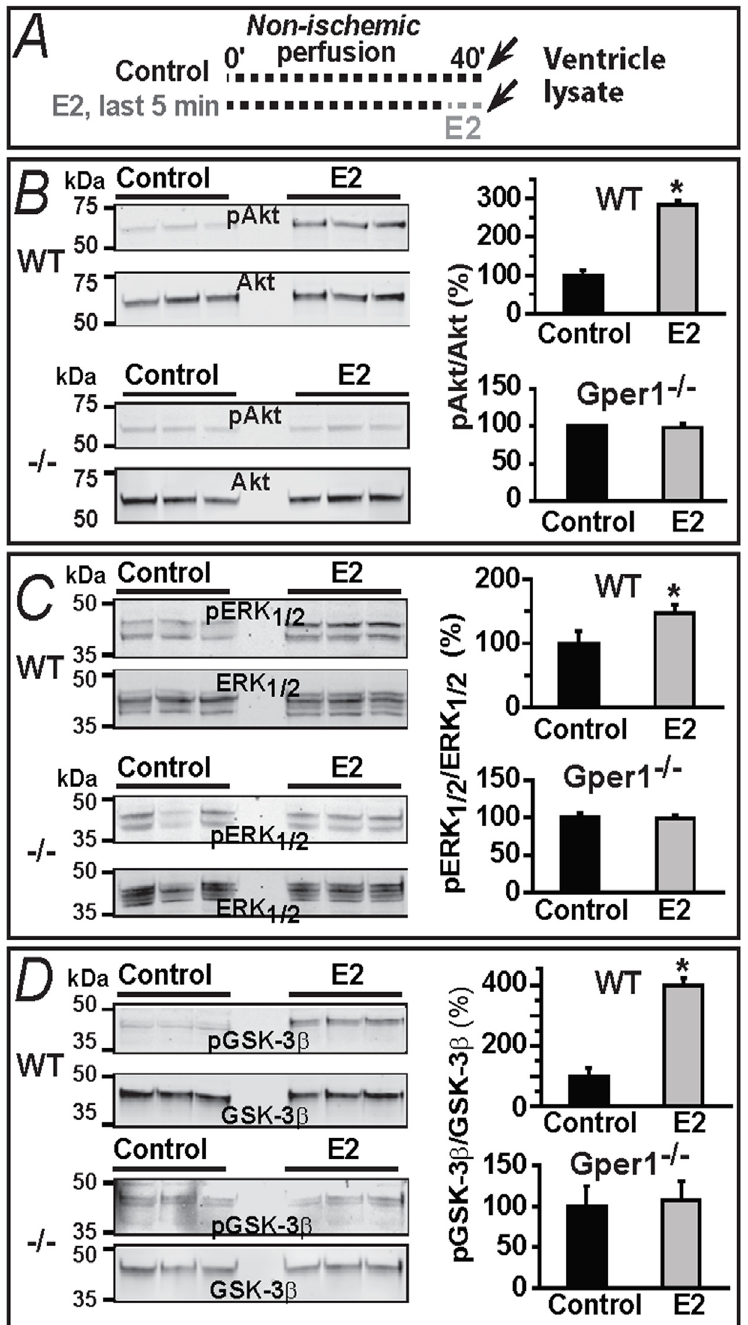
Fig 6. E2-induced increase in phosphorylation of Akt, ERK 1/2 and GSK-3 β is dependent on Gper1 gene expression and disappears with time for Akt and ERK 1/2 . A. Protocol used in panels B,C,D . Isolated hearts were either perfused 40 min with oxygenated KH solution or perfused with oxygenated KH for 35 min and for 5 min with KH plus 40 nM E2. B-D. Immunoblots and corresponding bar graphs show that 5 min “ pre- ischemic ” treatment with E2 provoked pAkt/Akt, pERK 1/2 /ERK 1/2 and pGSK-3 β /GSK-3 β ratios to increase in WT but not in Gper1 -/- samples. Control ratios were set to 100%. Values are mean ± S.E.M.; * , P < 0.05 control versus E2-treated group, n = 7